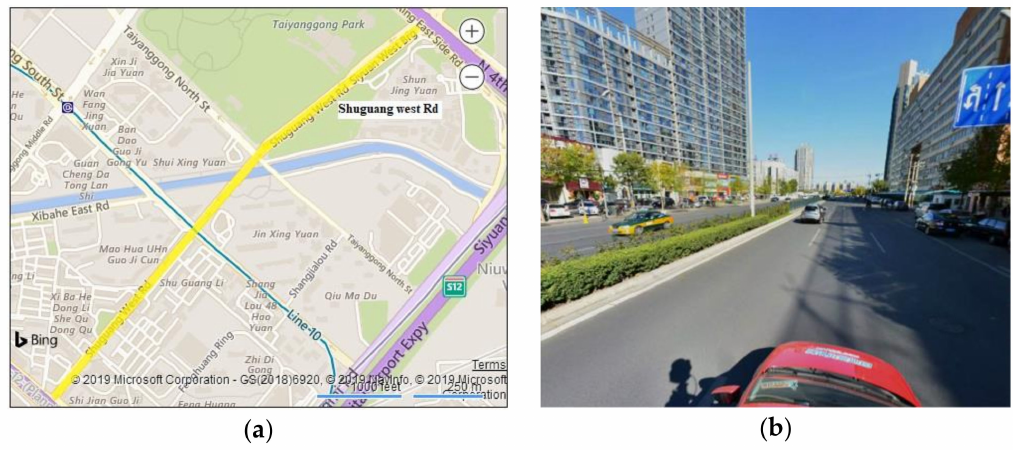
Figure 2. Driving test environment. ( a ) is a map of its location in Beijing and ( b ) is a picture of the